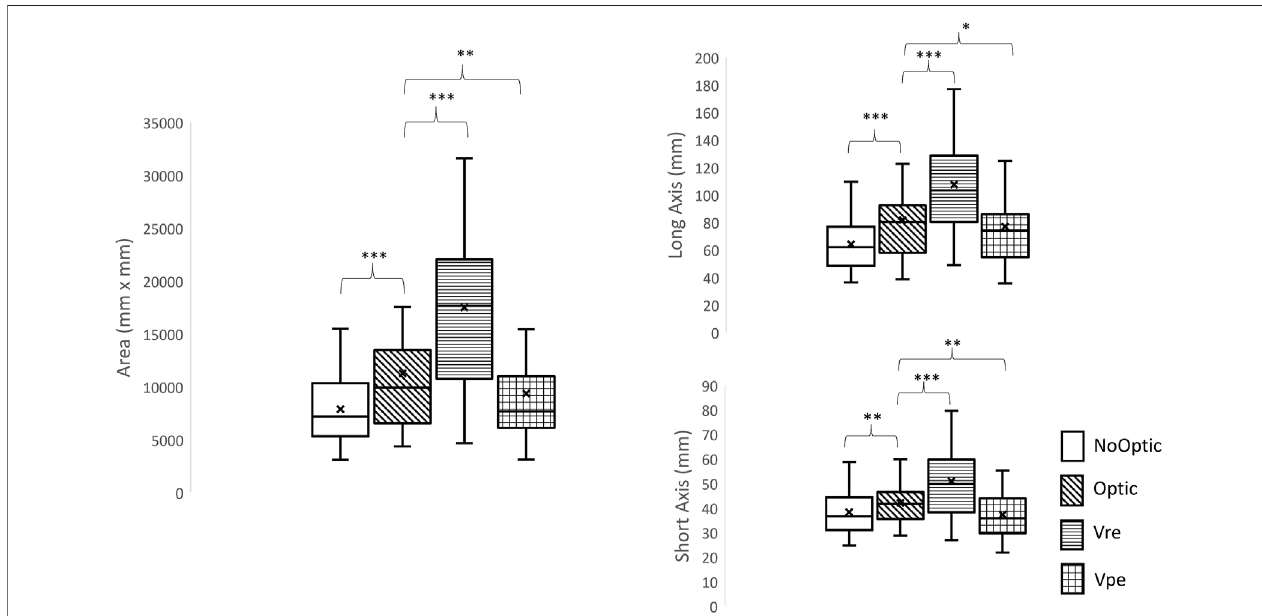
FIGURE3| Theellipsearea,thelengthoflongaxisandthelengthofshortaxis.*:signi fi cantdifferencecomparedtooptic fl owcondition,*: p < 0.05,**: p < 0.01;***: p < 0.001.